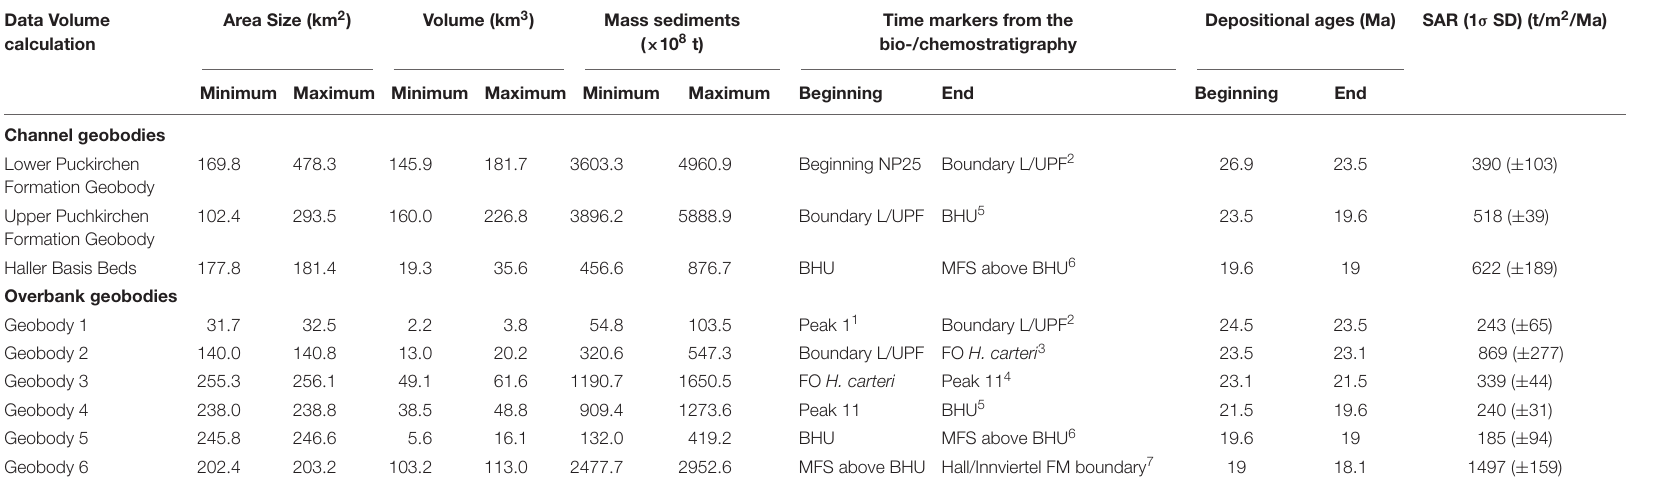
Depositional ages